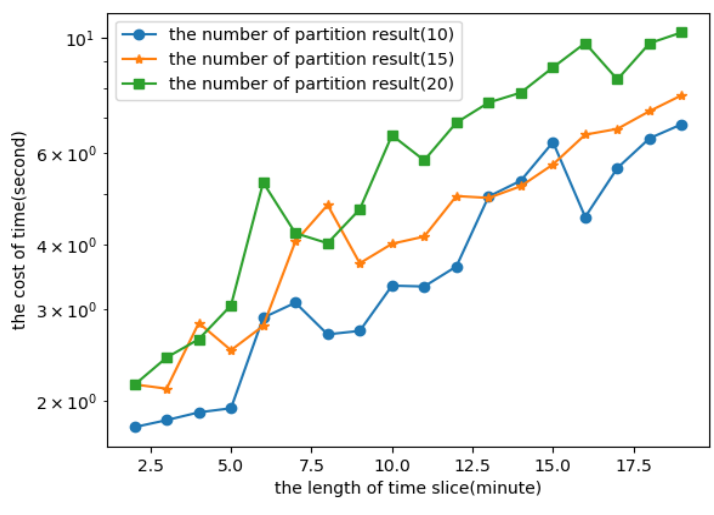
Figure 10. The cost of time (Geolife dataset).